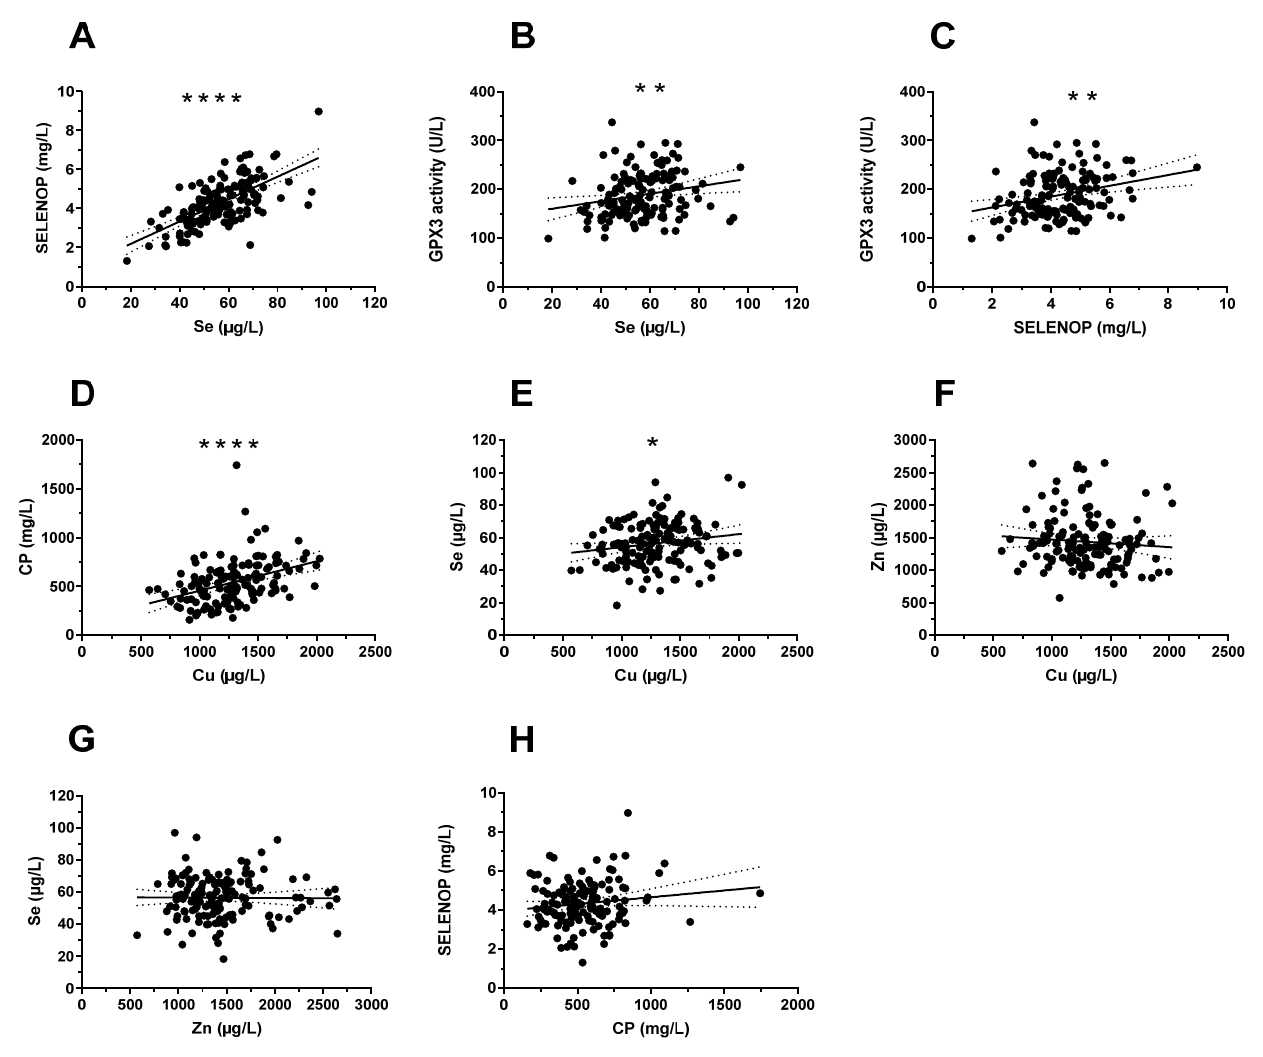
Figure 3. Interrelations between serum biomarkers of Cu, Se, and Zn status in paediatric patients. The analyses comprised three serum biomarkers of Se and two of Cu status, along with total serum Zn concentration. ( A ) The direct comparisons of Se and SELENOP ( r = 0.655, p < 0.0001), or ( D ) Cu and CP ( r = 0.389, p < 0.0001) yielded strong linear correlations over the full range of data. Similarly, ( B ) GPX3 activities and serum Se ( r = 0.2507, p = 0.0026) as well as ( C ) GPX3 activities and SELENOP concentrations ( r = 0.2495, p = 0.0027) showed positive correlations. A significant, albeit weak, interaction was observed between ( E ) Cu and Se. No interrelation was observed between ( F ) Cu and Zn, ( G ) Zn and Se, or ( H ) CP and SELENOP concentrations. Correlation coefficients were calculated by Pearson correlation test for normally distributed values, and by Spearman test for non-normally distributed values. Significance is indicated by p -values; **** p < 0.0001, ** p < 0.01, and * p < 0.05.